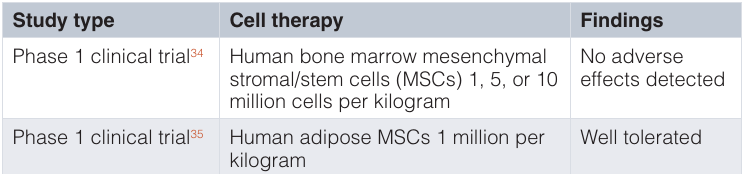
Table 3. Mesenchymal stromal/stem cell safety in clinical